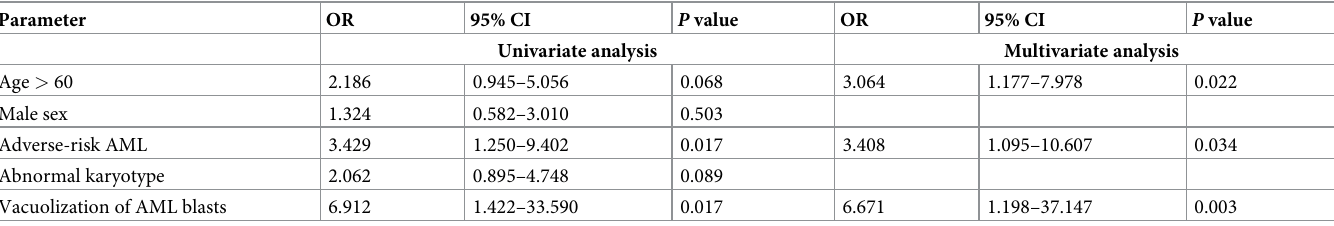
Table 6. Logistic regression analysis of risk factors for failure of day 15 bone marrow blast clearance.